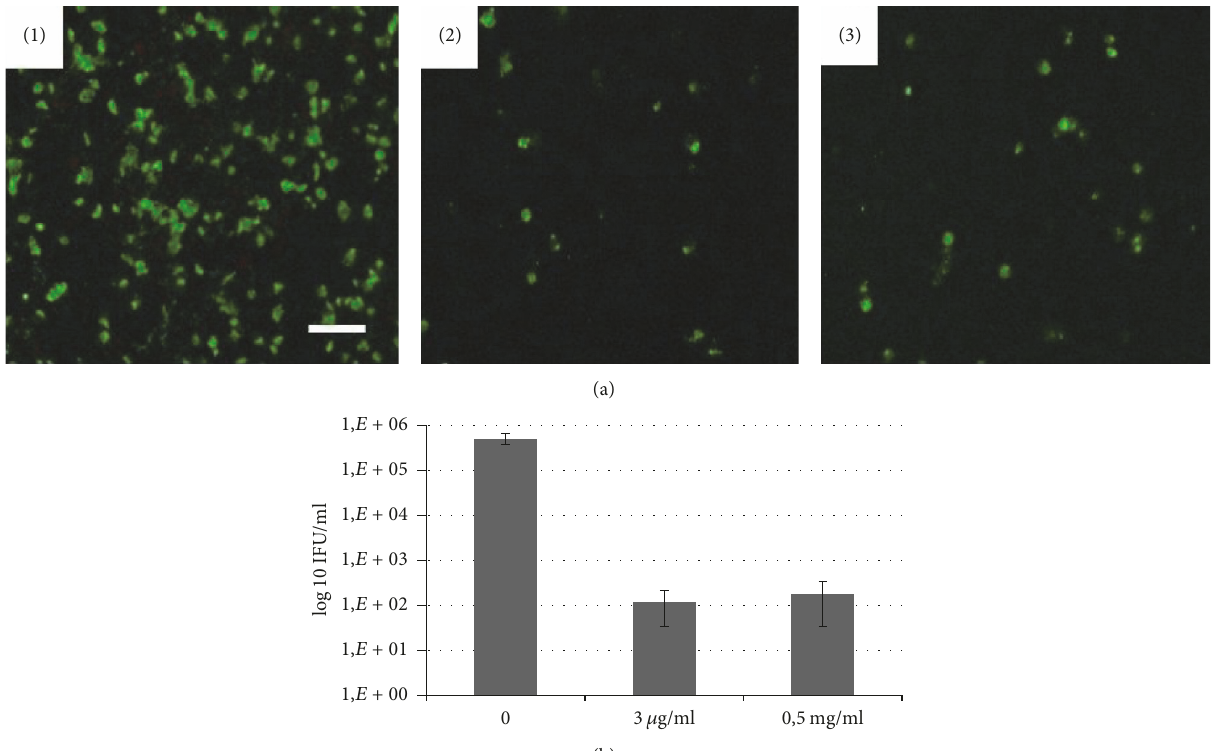
Figure 6: Inhibition of C. pneumoniae growth in B10.MLM cells in the presence of two formulations of lycopene. (a) C. pneumoniae infection in B10.MLM cells at 72 h.p.i. (1) growth without lycopene; (2) 3.0 𝜇 g/ml of oil-formulated lycopene; and (3) 0.5 mg/ml of microencapsulated lycopene. Scale bar 100 𝜇 m. (b) Infectious yield after treatment with two formulations of lycopene.